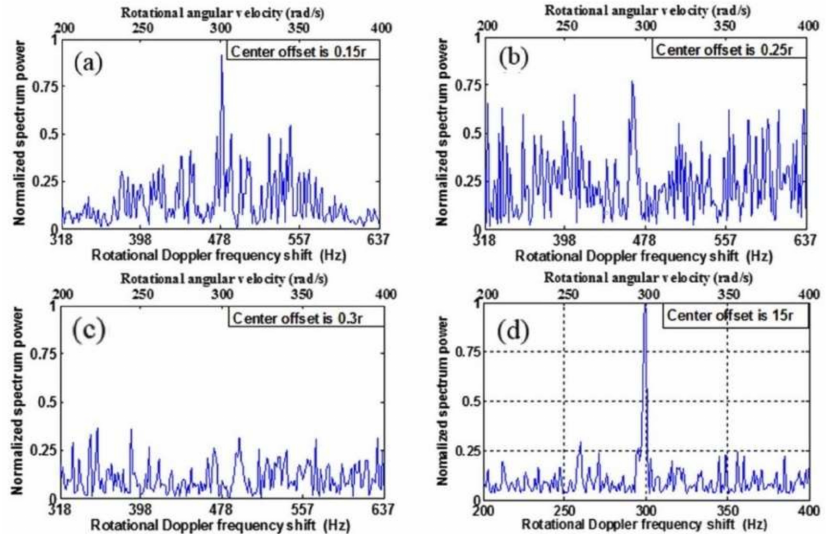
Figure 15. Rotational Doppler spectrum under different lateral misalignments . ( a ) d = 0.15 r . ( b ) d = 0.25 r . ( c ) d = 0.3 r . ( d ) d = 15 r . Adapted with permission from Ref. [53].